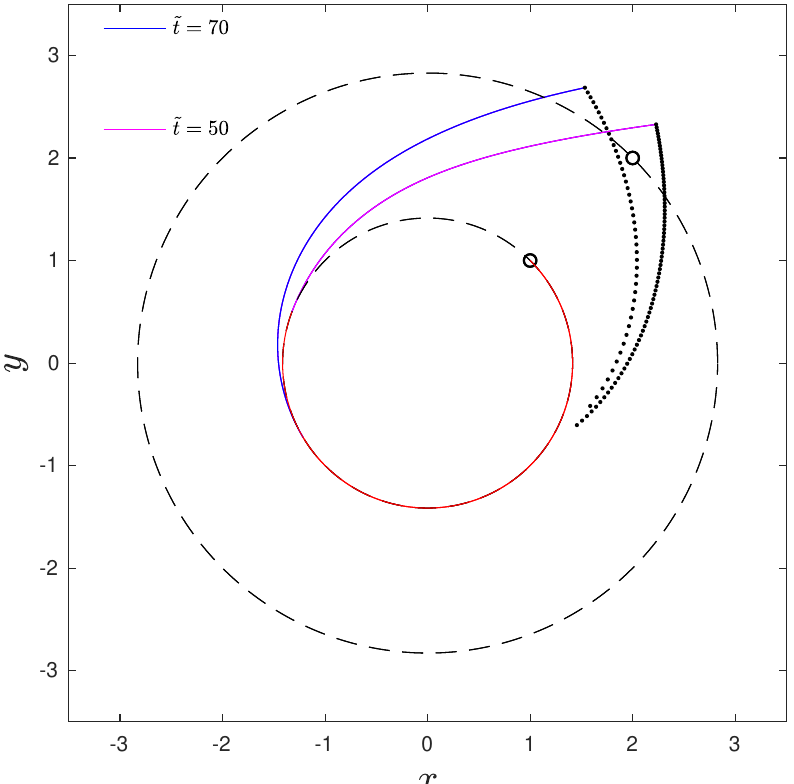
Figure 2. We want to move the particle from ( 2,2 ) to ( 1,1 ) . The red line represents the motion of the particle in the second regime, while the blue and pink lines represent two possible trajectories in the first regime for different C θ and ˜ t . The black dots represent possible initial positions for the particle for different values of these parameters. We see that a change in C θ affects the radial coordinate, while a change in ˜ t affects the angular coordinate of the simulated initial